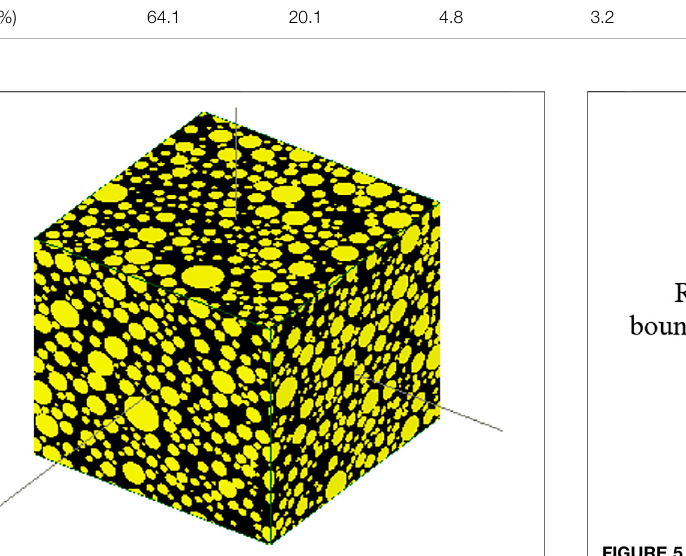
FIGURE 4 | Simulated concrete substrate, where the spheres represent coarse aggregates and the rest space represents mortar.